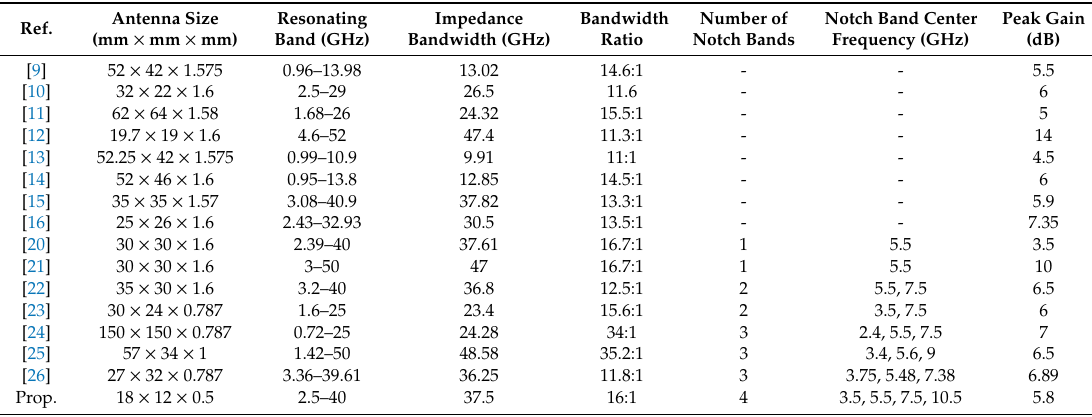
Table 2. Comparison between the proposed quad notched-band SWB antenna and previous works related to the SWB antenna. Antenna Size Resonating Impedance Bandwidth Number of Notch Band Center (mm × mm × mm) Band (GHz) Bandwidth (GHz) Ratio Notch Bands Frequency